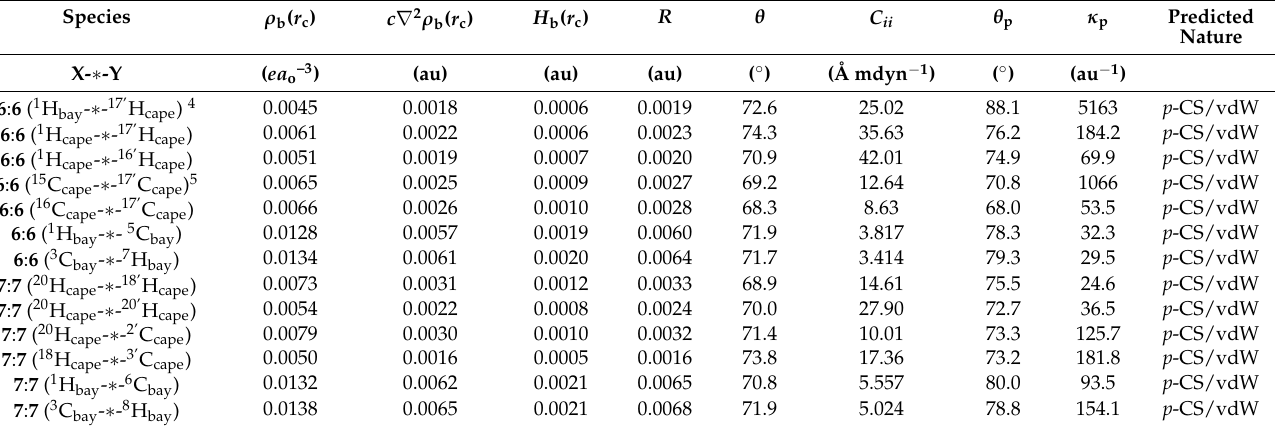
Table 2. QTAIM Functions and QTAIM-DFA Parameters Evaluated for the Fused Benzene-Type Helicenes of Concave-Type Dimers ( 6 : 6 and 7 : 7 ), Employing the Perturbed Structures Generated with CIV 1–3